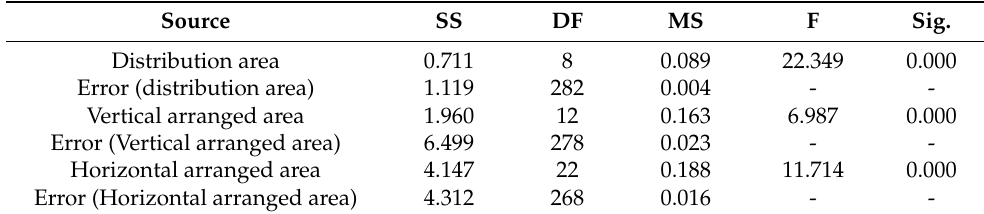
Table 1. Summary of ANOVA results for movement time.